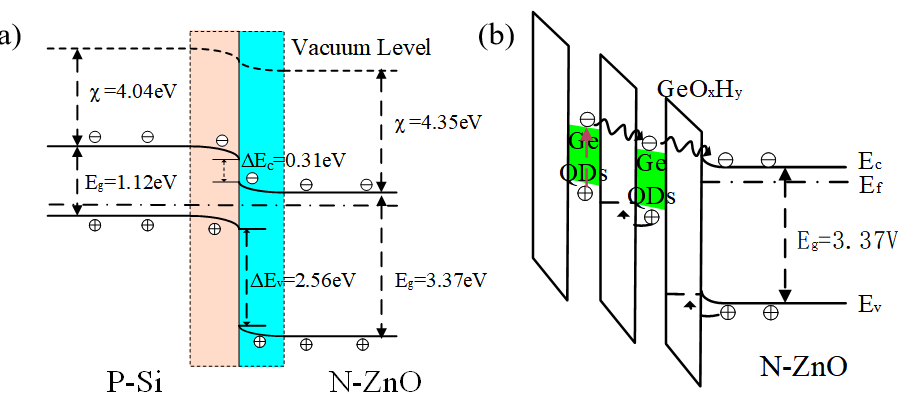
Figure 5. Energy band diagram of Si/ZnO NWs’ ( a ) and ZnO NWs/Ge QDs’ ( b ) hybridization structure under UV and NIR light illumination, respectively.